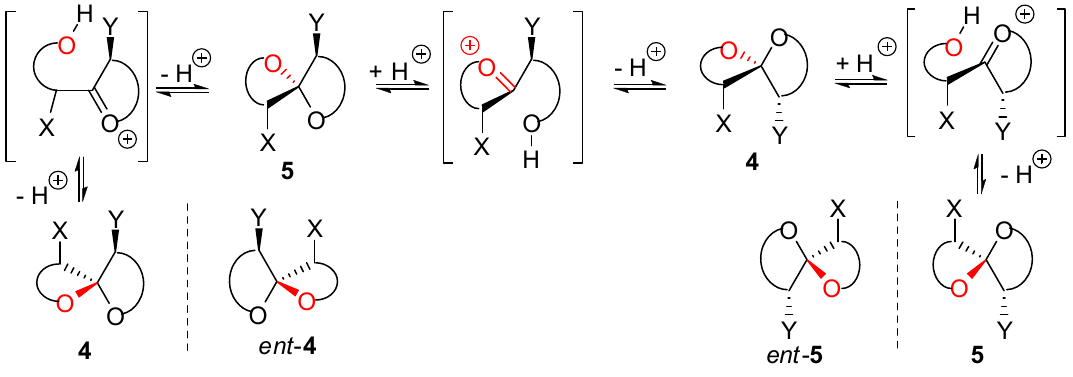
Figure 3. Epimerization of spiroacetals through acid-catalyzed heterolysis.